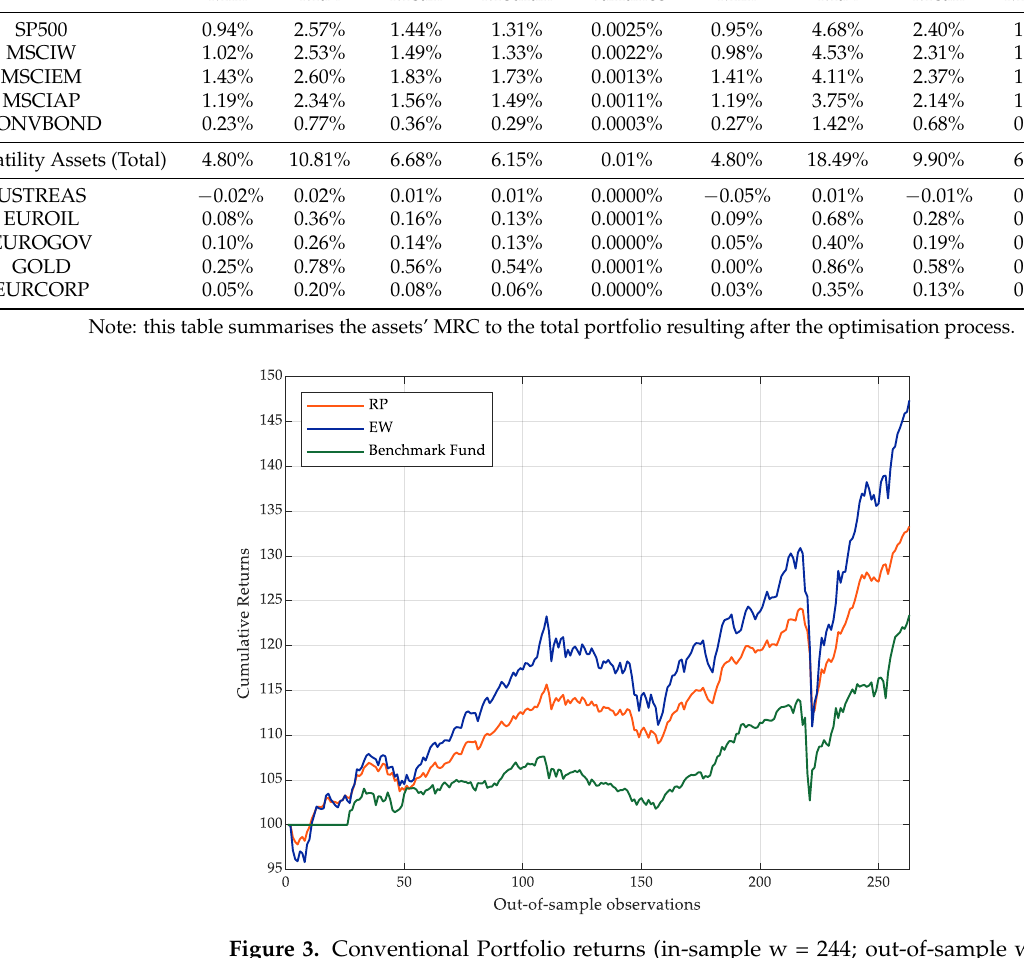
Figure 4. Conventional Portfolio returns (in-sample w = 130; out-of-sample w = 132). Notes to im- prove table clarity, returns were normalised on a scale of 100. 3.3. Combined Portfolio ERC Optimisation In the second step, we focused on the Combined Portfolios . Following the aim to build and test the performance, diversification benefits, and decoupling effects, we added four Islamic stock indexes corresponding to the Shariah-compliant counterparts of equities components already in the portfolio ( SPS500 , MSCIWI , MSCIEMI , and MSCIAPI — Table